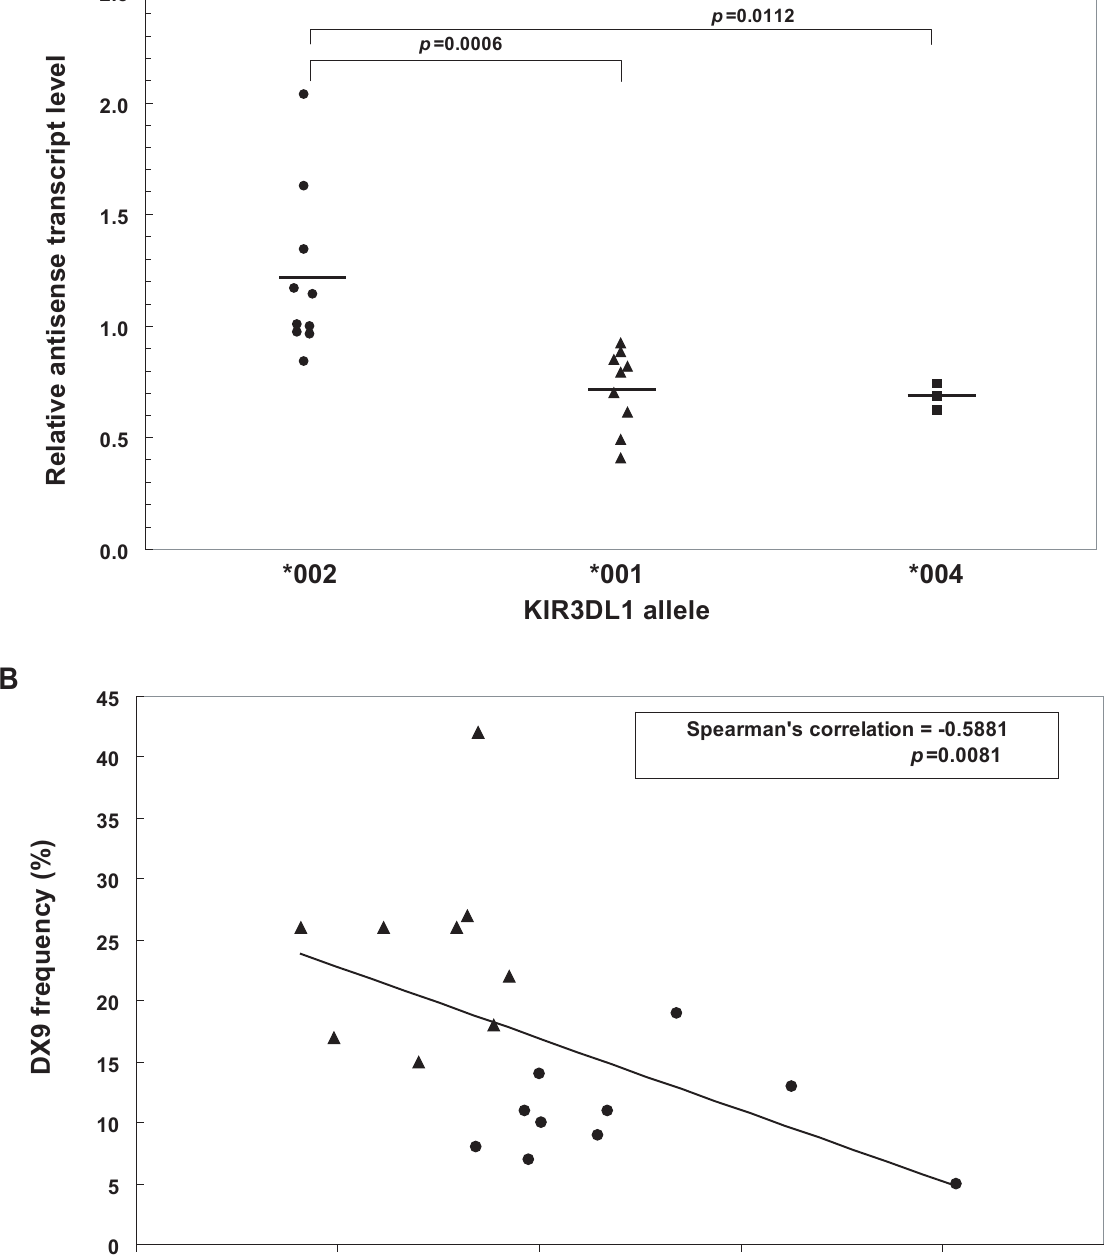
amongst alleles of a single KIR gene, produce differences in the functional activity of the bi-directional KIR promoters that are associated with distinct frequencies of receptor expression.